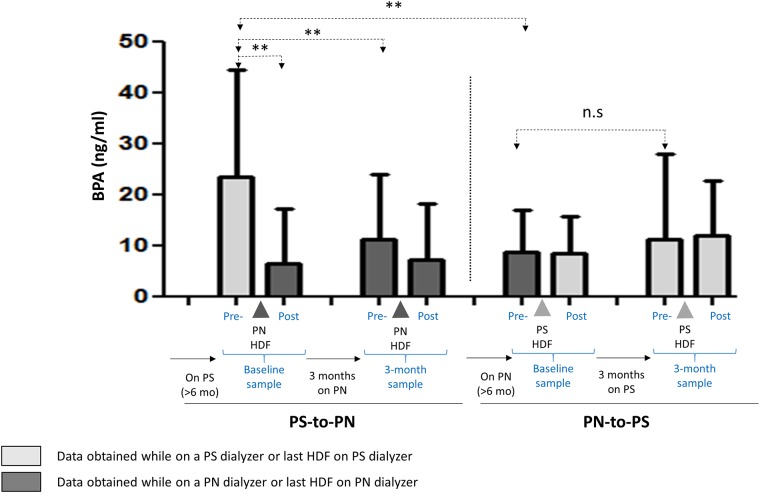
Plasma BPA concentration in patients on OL-HDF with polynephron (PN) or polysulfone (PS) membranes.Pre- and post-dialysis measurements are shown for the first (baseline) and the last (3-month) session after the switch. Prior to the baseline pre-dialysis sample, patients had been on OL-HDF with the opposite membrane for >6 months. Thus, baseline pre-dialysis values represent values corresponding to >6 months OL-HDF with the opposite membrane and were used as baseline values for the switch study, while baseline post-dialysis values were already obtained after the first session with the switch membrane. Data expressed as mean±SD. ** p<0.01. Pre- and Post- refers to pre-dialysis and post-dialysis (OL-HDF) session.